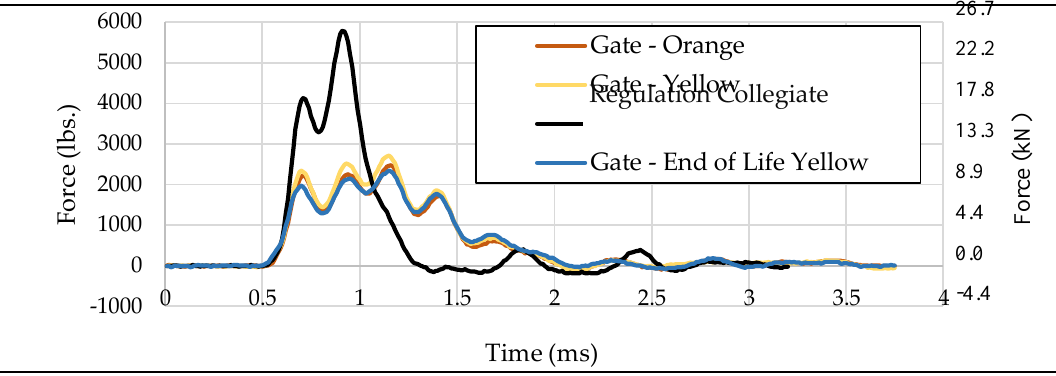
Figure 4. Impact characterization: Force/Time curve for impacts.